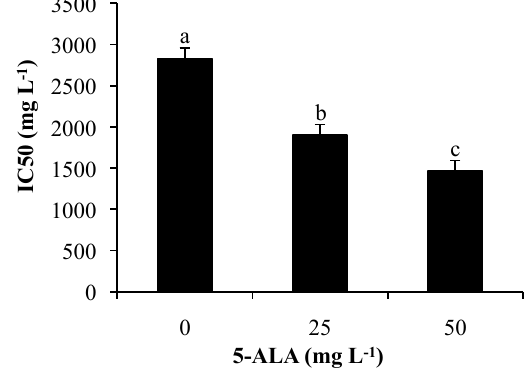
*Means followed by the same letter are not significantly different according to DMRT at P≤ 0.05. Data are mean ±standard deviation of eight replications.